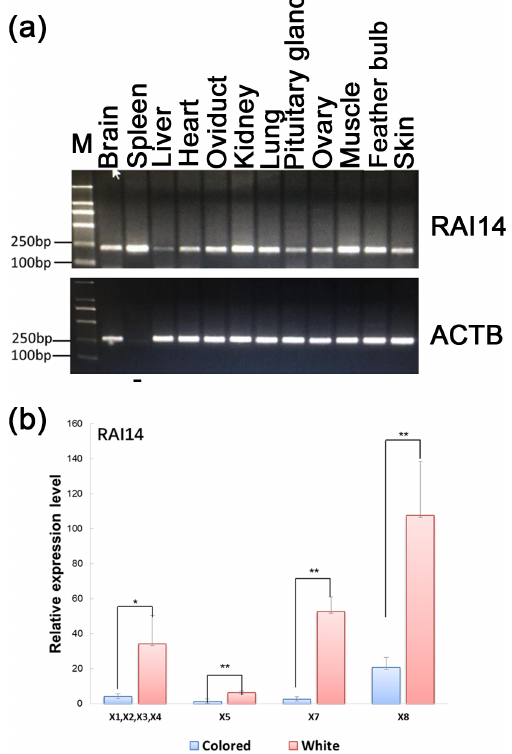
Figure 3. Expression of RAI14 mRNA detected in feather bulbs and different tissues. (a) RAI14 mRNA expression profiles in different tissues by RT-PCR. Lengths of the PCR products ( RAI14 : 204bp; beta-actin: 212bp) ( − ), no cDNA samples are marked in the figure; M represent molecular weight (MW): 2000bp. (b) Expression of RAI14 mRNA in the feather bulb by qPCR. All samples were nor- malized by beta-actin. Each bar represents the relative expression level of the RAI14 gene mRNA. Error bars represent standard error of the mean (SE). X1, X2, X3, X4, X5, X7, and X8 denote RAI14 mRNA isoforms. ∗ represents significant at p< 0 . 05 and ∗∗ repre- sents significant at p< 0 . 01, based on assuming unequal variances and Student’s t